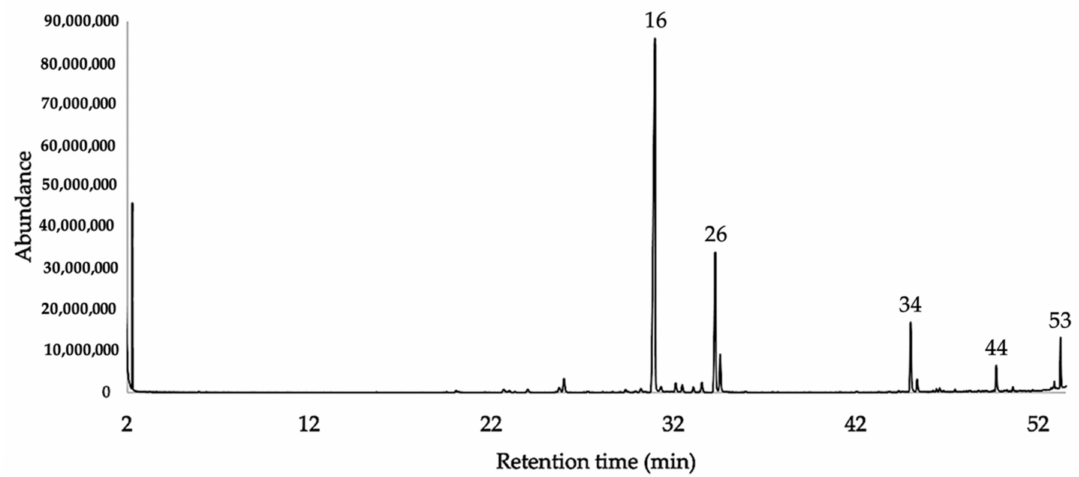
Figure 2. GC-MS chromatogram of J. rugosa EO on HP-INNOWax column. Table 1. Qualitative and quantitative chemical analyses of the EO from J. rugosa fresh leaves.